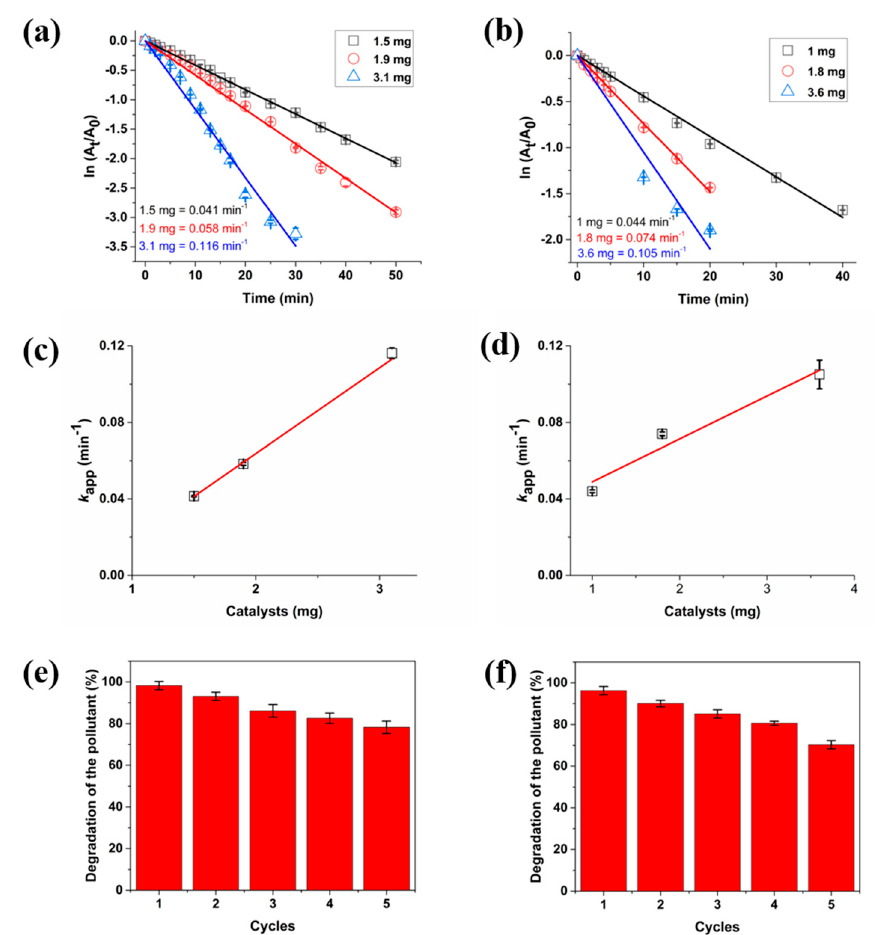
Figure 6. The pseudo-first-order kinetic curves of the catalytic reduction of ( a ) MB and ( b ) 4-NP, k app values of ( c ) MB and ( d ) 4-NP under different Ag@KS concentrations; and degradation percentage of ( e ) MB and ( f ) 4-NP over five reduction cycles .